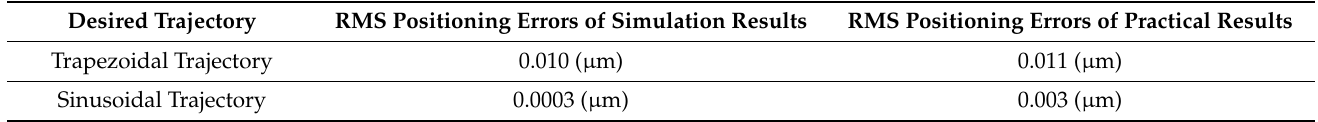
Figure 20. Micro-positioning error for a desired sinusoidal-type trajectory . The RMS (root mean square) statistics of positioning errors in the steady state for the above-mentioned simulation and experiments with 100 runs are listed in Table 3. Table 3. The RMS statistics of positioning errors in the steady state.